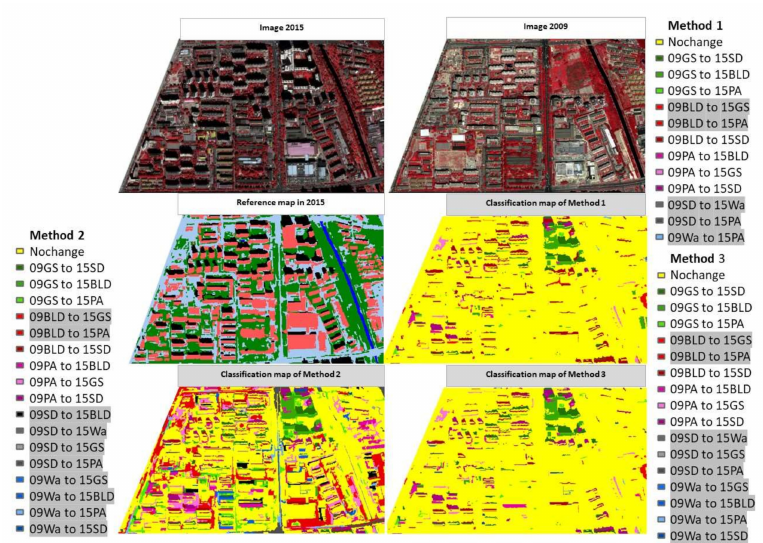
Figure 9. The change analysis results from three methods. The false types of change that did not occur were marked in